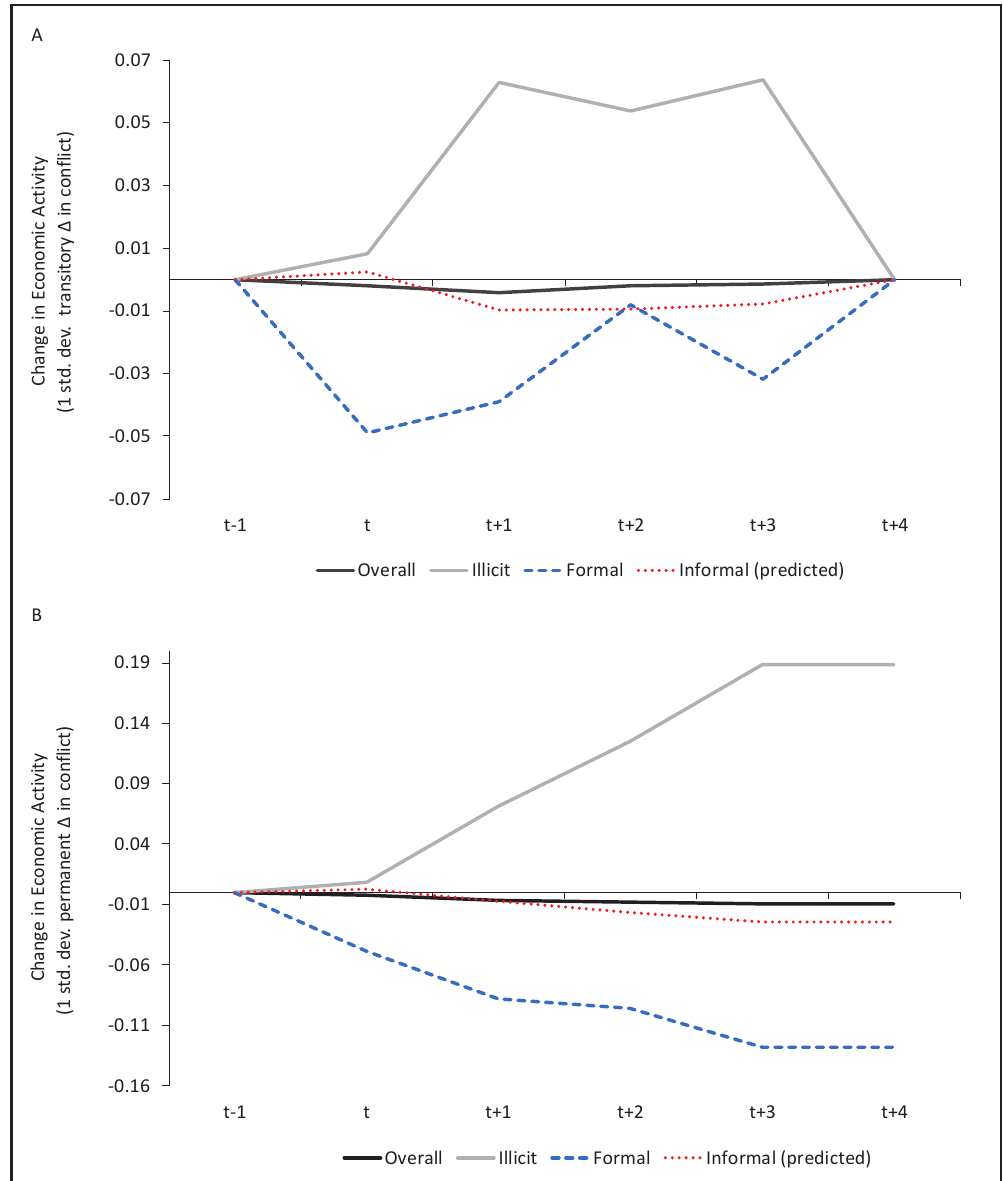
The impact of a surge in conflict on economic activity. (A) Temporary surge in conflict. (B) Permanent surge in